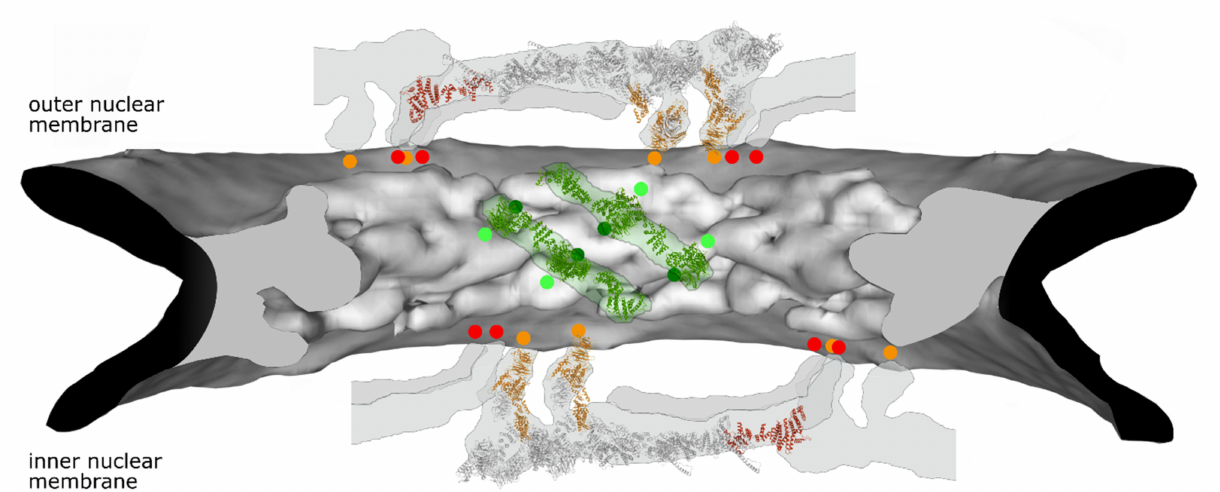
Figure 2. Selected membrane contact sites within the NPC structure model. Electron density of the NPC inner ring is shown in grey (generated from PDB:7PER). The position of four Nup155 molecules in green as well as their membrane contact sites (light green dots) is shown. Predicted Nup53 membrane contact sites (dark green dots, based on [39]) are similarly indicated. For the outer rings (generated from PDB: 7PEQ) the position of two complete Y-complexes with parts of their neighboring units are shown. Nup160 (orange) and Nup133 (red) with the respective membrane contact points are indicated. Please note that the position of the second Nup133 in one of the Y-complexes as well as the position of Nup53 in the inner ring cannot be unambiguously assigned in this structural model. Similarly, the current NPC structure models do not show the position of